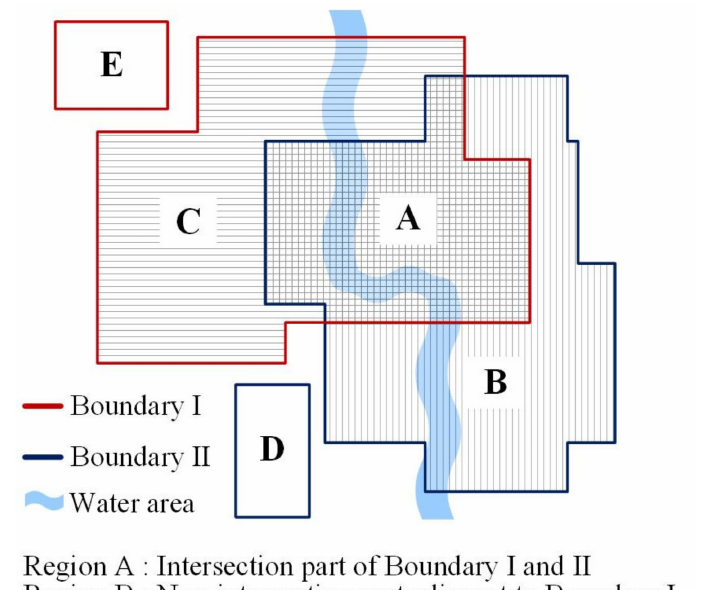
Figure 5. Process of merging the extraction